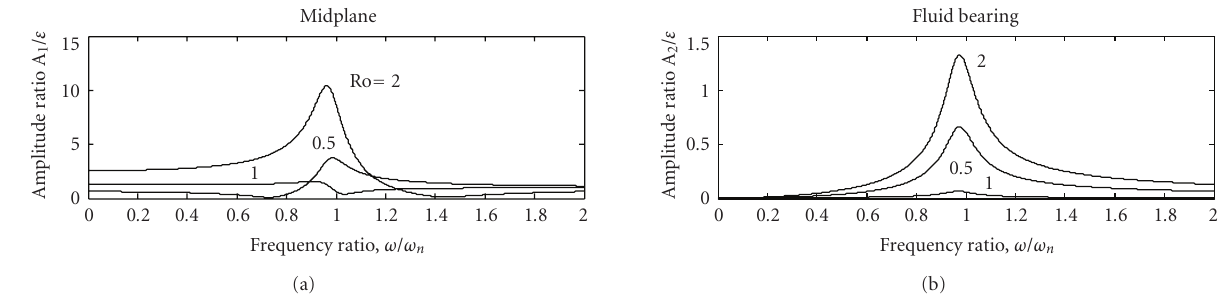
Figure 3: Response curves with bow opposite imbalance for various amounts of bow, Ro.